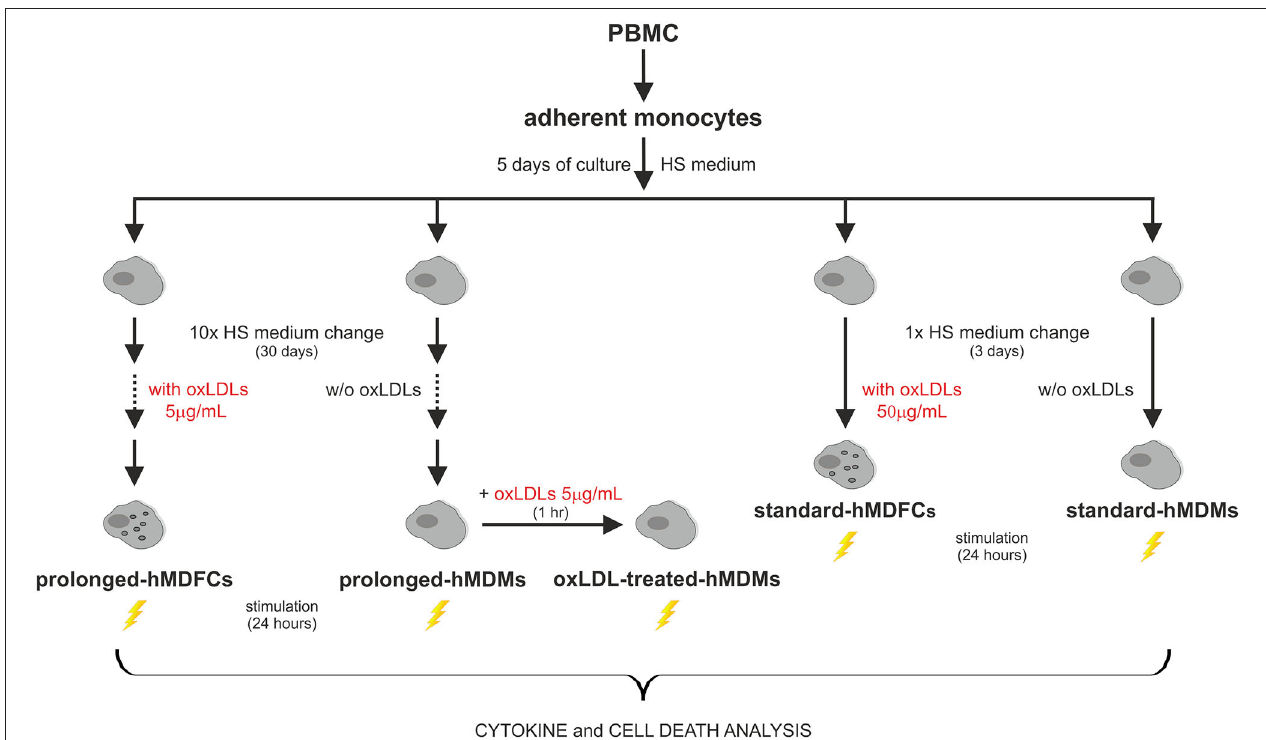
FIGURE 1 | The outline of experimental